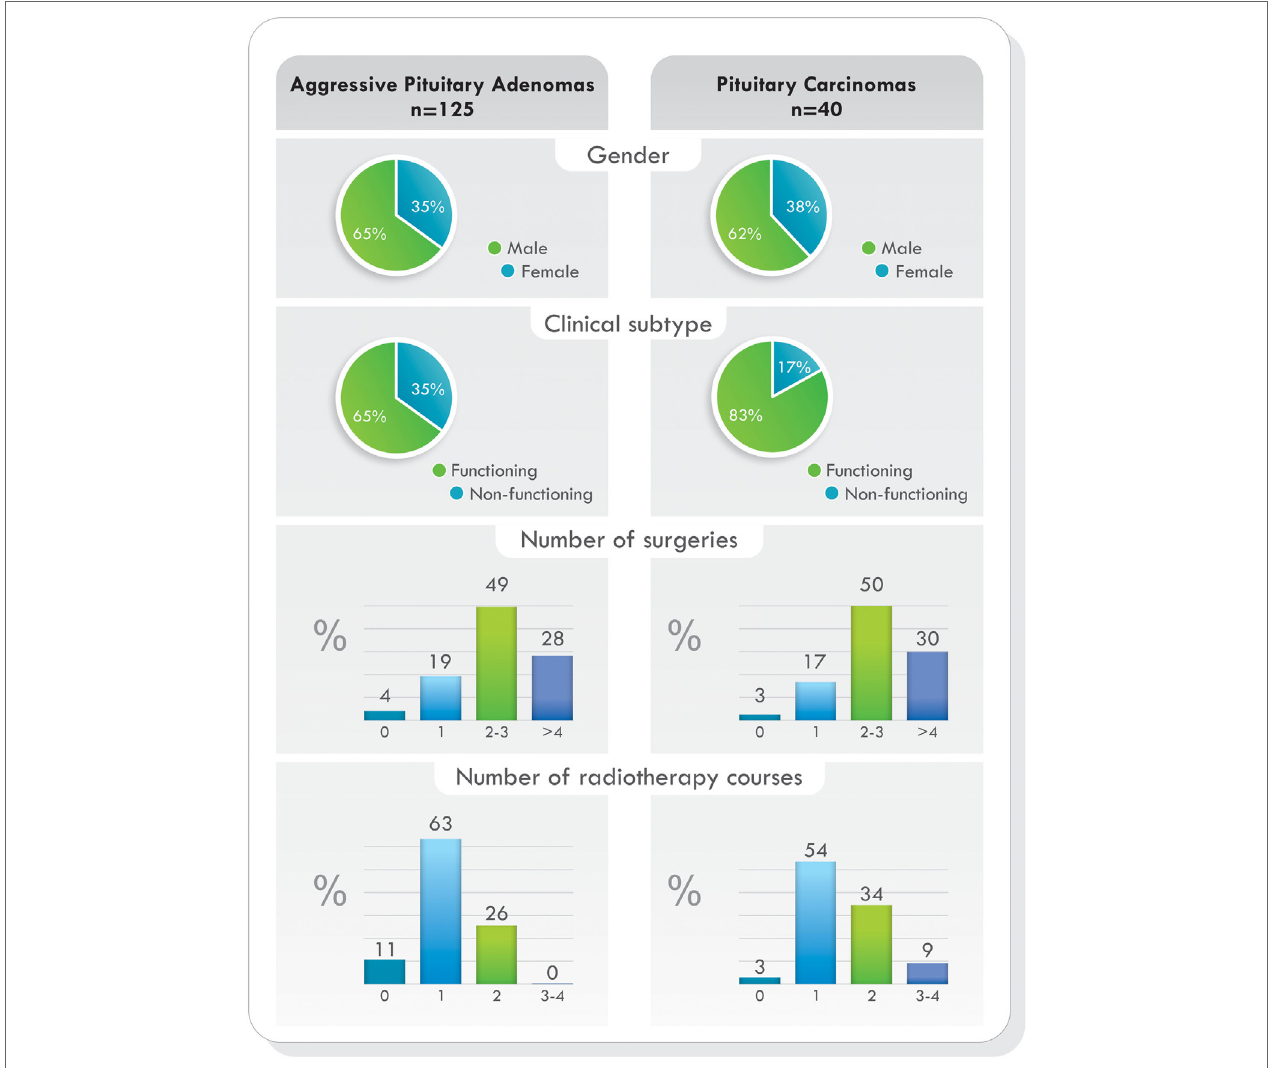
FiGURe 4 | Temozolomide-treated patients. Demographics, clinical presentation, previous surgeries, and radiotherapy comparing aggressive pituitary adenomas and pituitary carcinomas. Data from Ref.